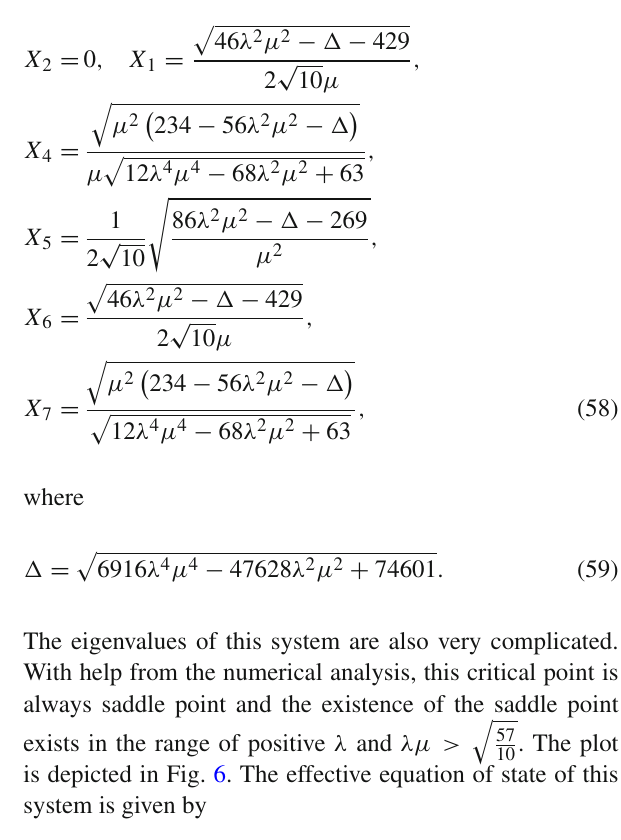
are stable. On the right panel, the graph b illustrates the changes of 2 effective equation of state over λ and μ . Noted that the black line in graph b indicates the border between saddle and stable critical points